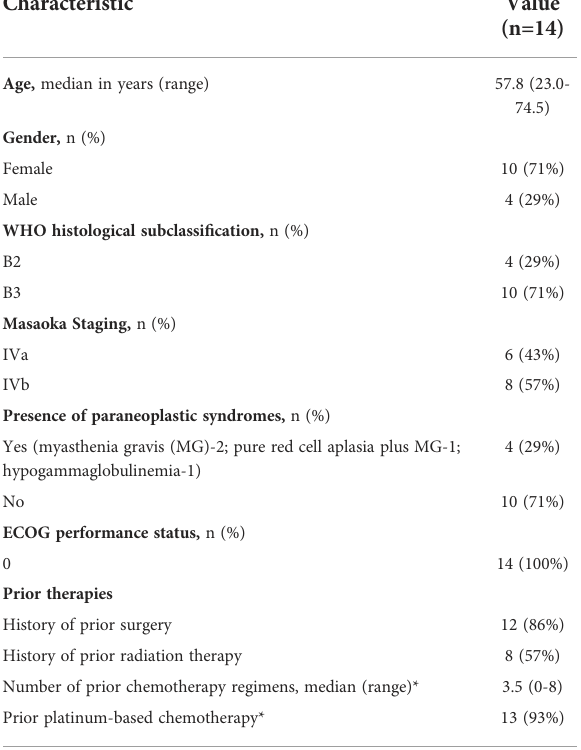
TABLE 1 Subjects characteristics at time of enrollment to the